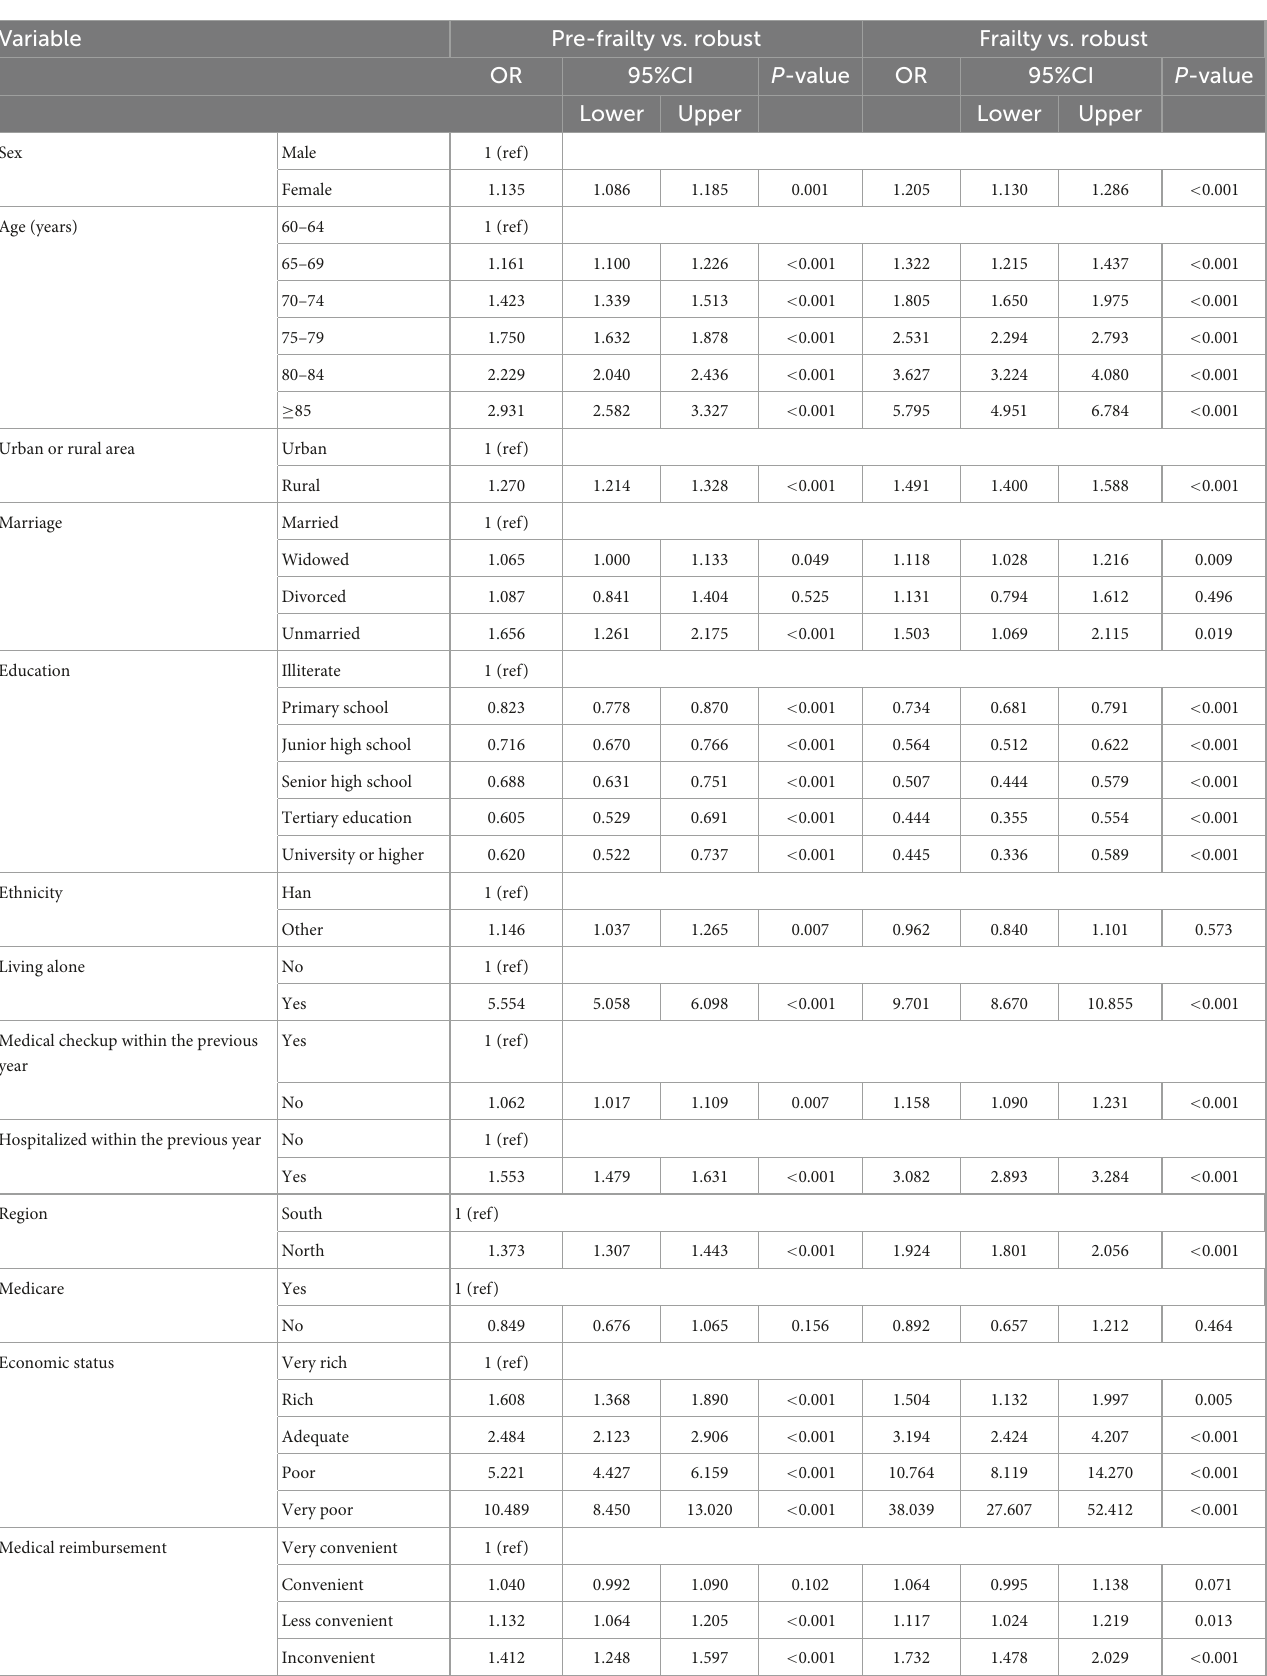
TABLE 3 Related factors associated with frailty and pre-frailty by multinomial logistic regression of older adults with hypertension.